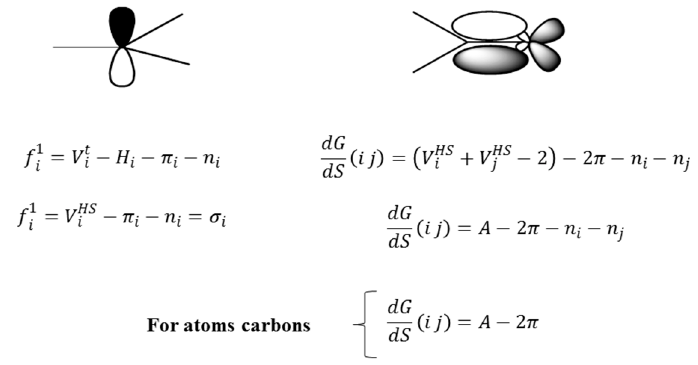
Figure 6. Own Frequency and duplex derivative in electronic terms.